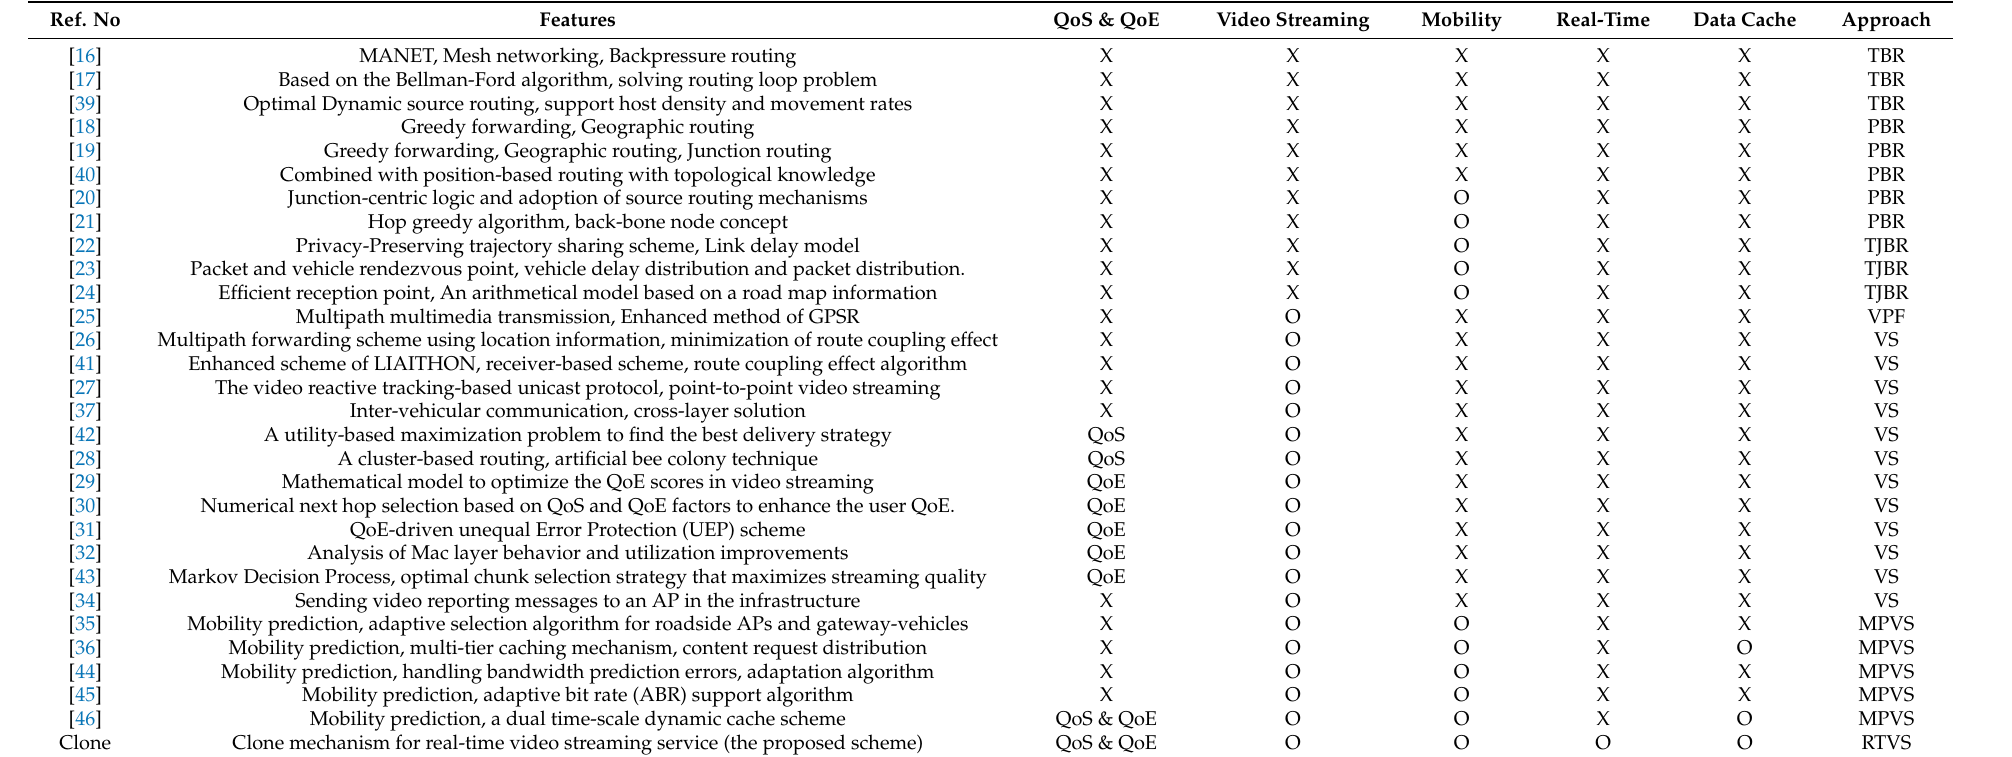
Table 1. The summary of the related works on video streaming services in